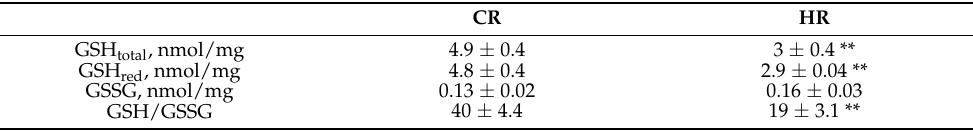
Table 3. The concentrations of GSH total , GSH red , GSSG and the GSH/GSSG ratio in liver mitochondria from control and hyperthyroid